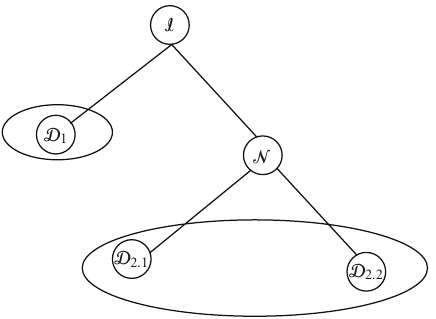
Figure 5: Extensive form representation of a cooperative network.